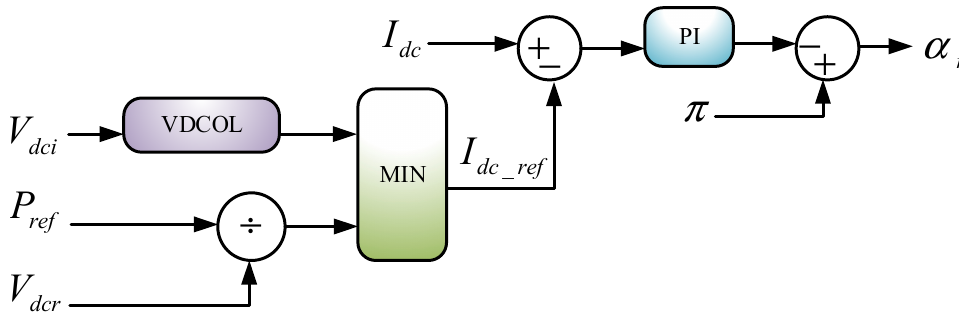
Figure 2. A simplified HVDC system model.